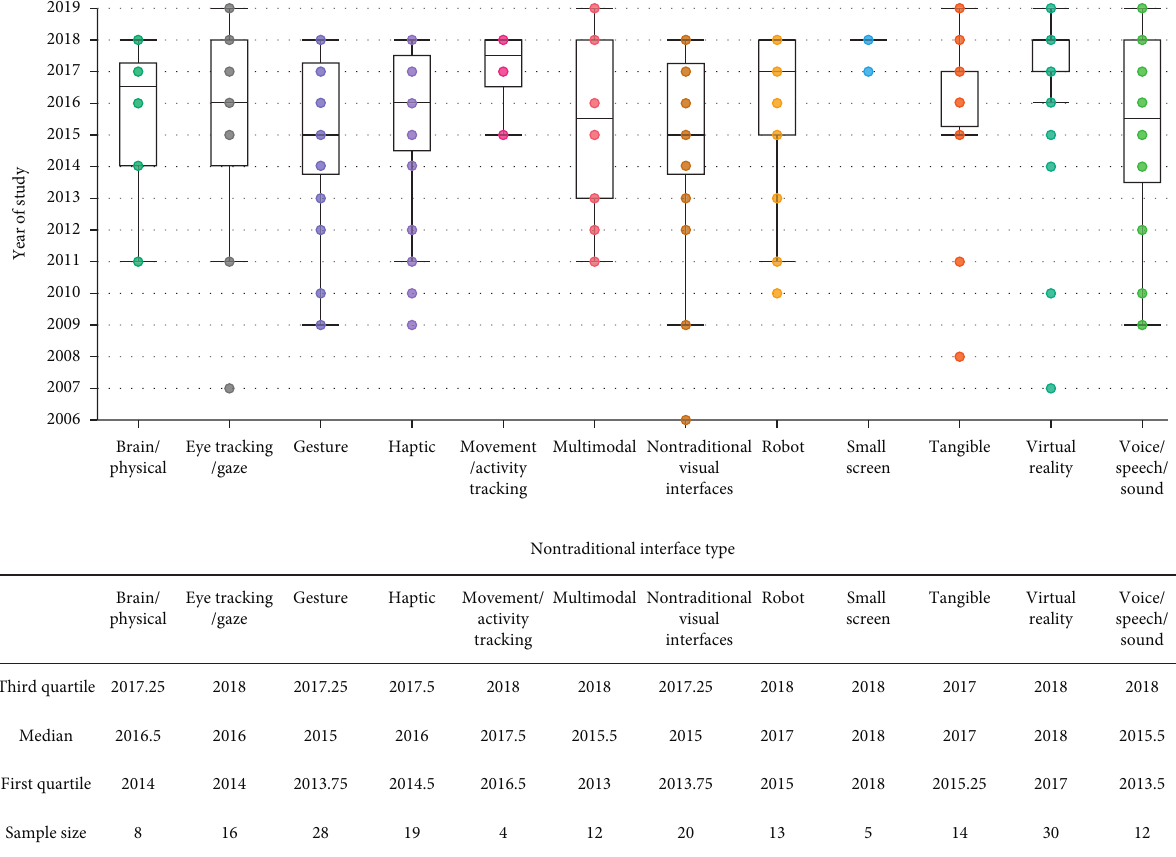
Figure 15: Studies with nontraditional interfaces by year. Table 9: Percentage of standardized questionnaires in studies with nontraditional interfaces. AttrakDiff